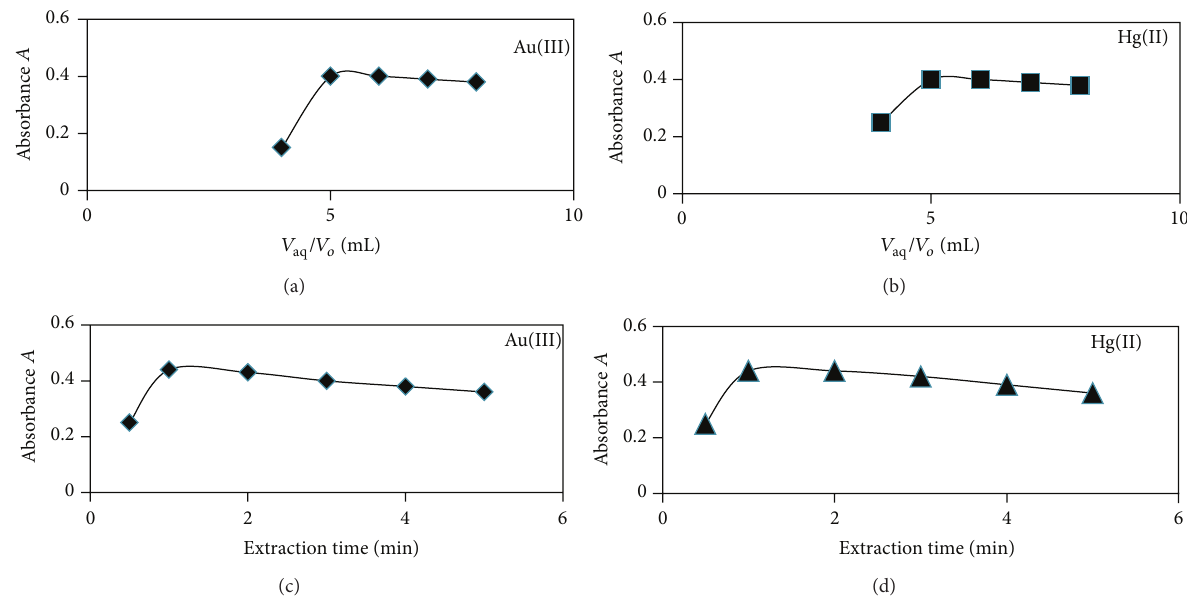
Figure 4: Phase ratio of aq: EA ( 𝑉 / 𝑉 𝑜 ) extraction effect and extraction time effects on absorbance of TC-Au(III) and TC-Hg(II) complexes. aq